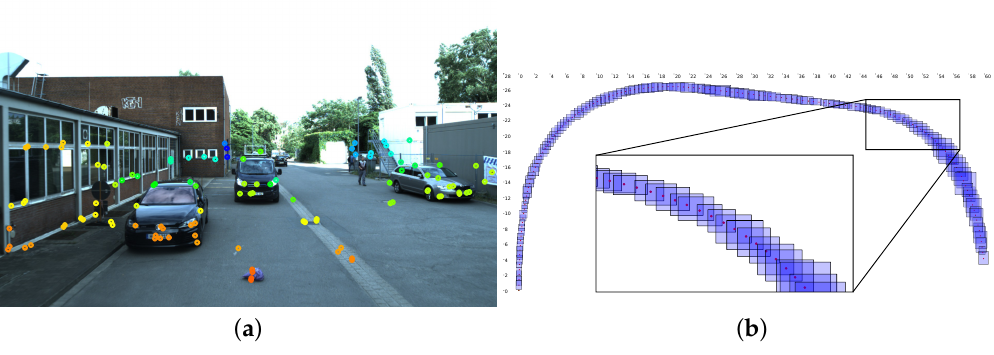
Figure 14. Results from the interval-based SLAM approach. ( a ) Image features color-coded by depth from close (red) via orange, yellow and green to distant (blue); ( b ) 2D position boxes (blue) that contain the vehicle’s true position